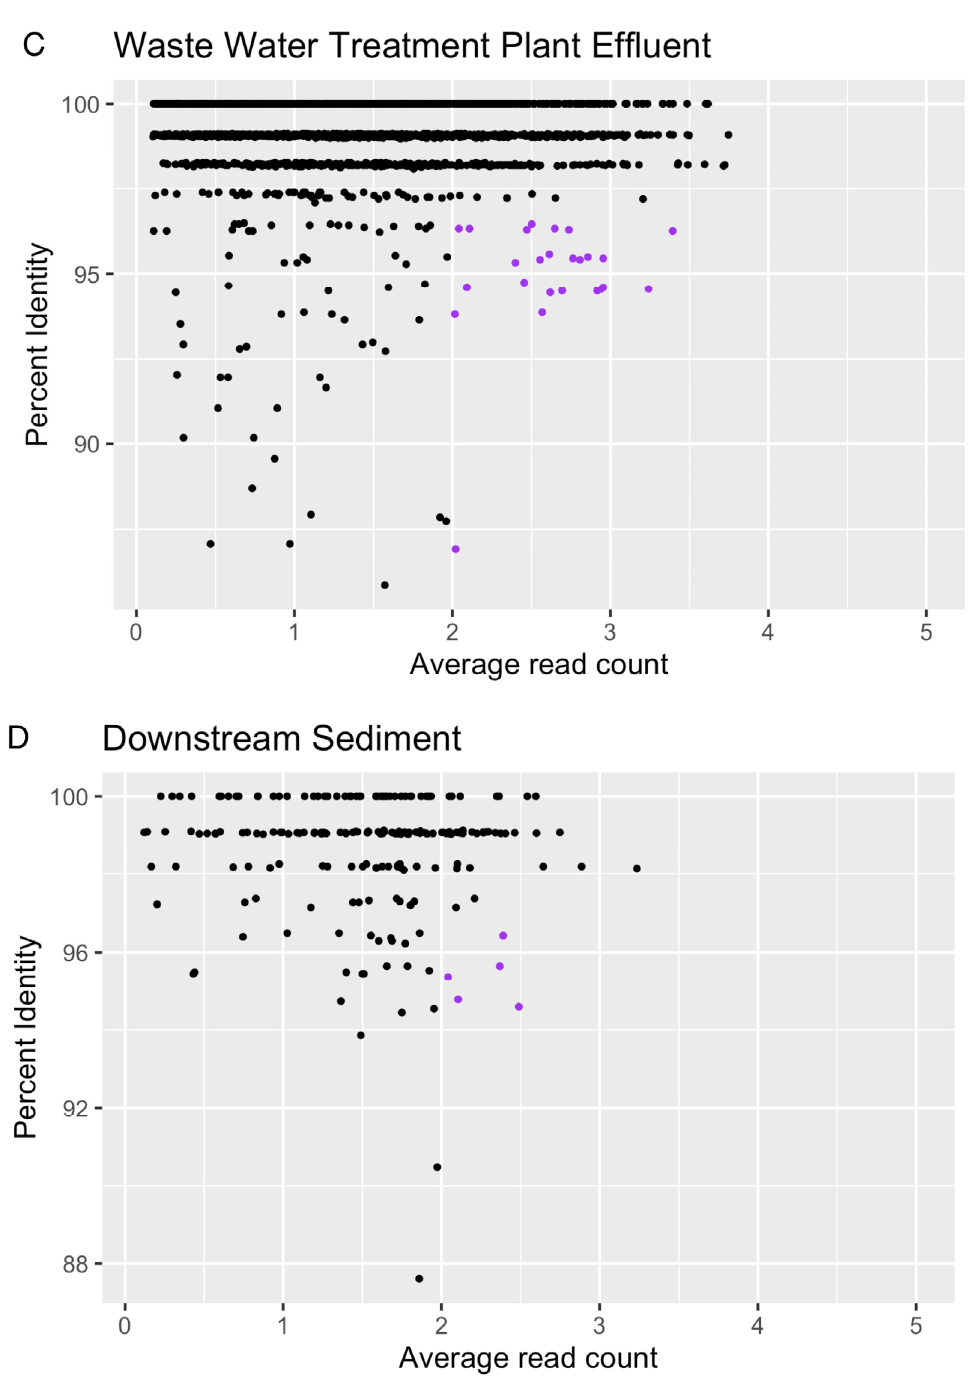
Figure 5. Percent identity to the SILVA database graphed against average read depth for all ASVs in the upstream ( A ), downstream ( B ), and wastewater treatment plant effluent ( C ), as well as AVSs present exclusively in downstream sediment communities ( D ). We only considered an ASV as possibly novel if the average read depth was > 100 and the percent identity to the SILVA reference database was < 97% (purple dots).